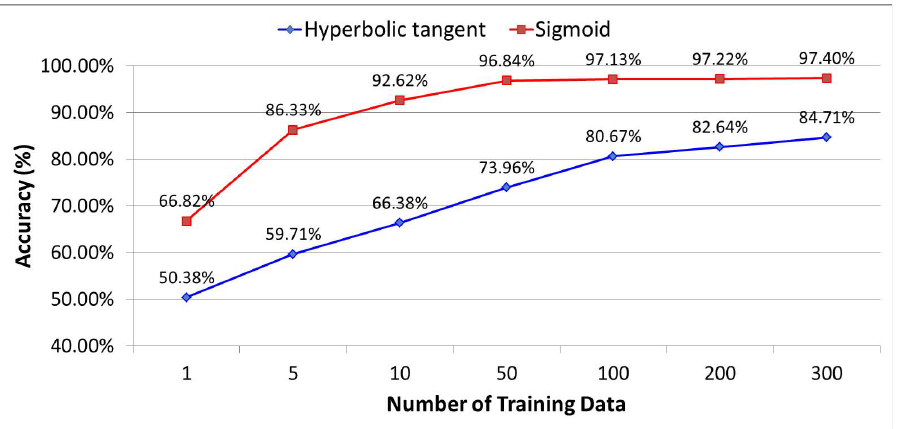
Figure 17. Comparative analysis of prediction accuracy between sigmoid function and hyperbolic tangent function.